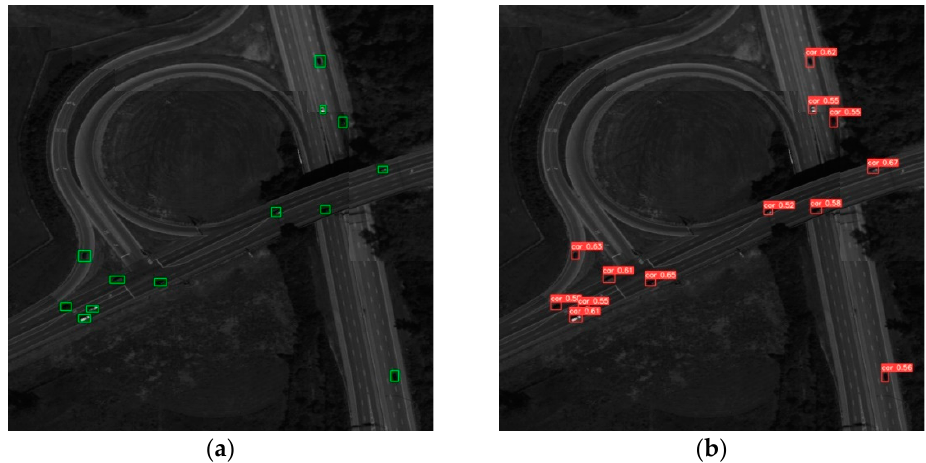
Figure 5. ( a ) Ground truth and ( b ) detection results. The detection results in scenes with dim targets of the proposed method.